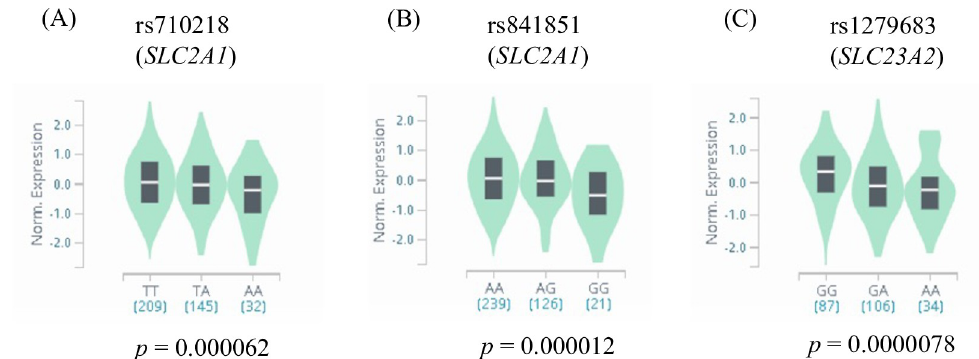
Fig 2. Genotype-specific differences in transcript levels of vitamin C transporter gene. These data were cited from the GTEx Portal on 11/01/2020 (https://gtexportal.org/). In the “GTEx” Portal database, a significant correlation was observed between the genotype of each SNV and the transcript level of SLC23A2 or SLC2A1 in human tissues. The p value indicates a significant difference between gene expressions by genotype. The genotype-expression association data for tissues with the lowest p values are presented for the 49 human tissues in the “GTEx” Portal database. (A) The transcription level of SLC2A1 in the left ventricle by rs710218 genotype. (B) The transcription level of SLC2A1 in the left ventricle by rs841851 genotype. (C) The transcription level of SLC23A2 in the spleen by rs1279683